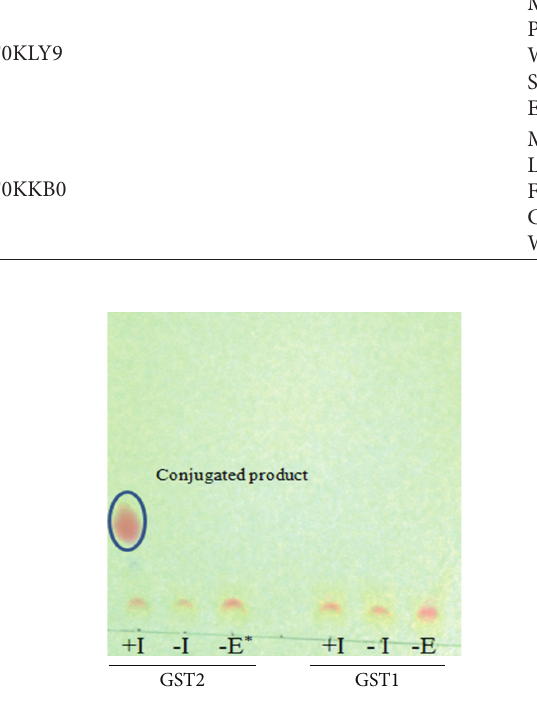
Figure 2: Thin layer chromatography indicating conjugation of isoproturon by GST2 (isoform pI 6.2) (circled spot). No conjugated product was seen when GST1 (isoform pI 4.5) was tested. +I = with isoproturon, − I = without isoproturon, − E = without